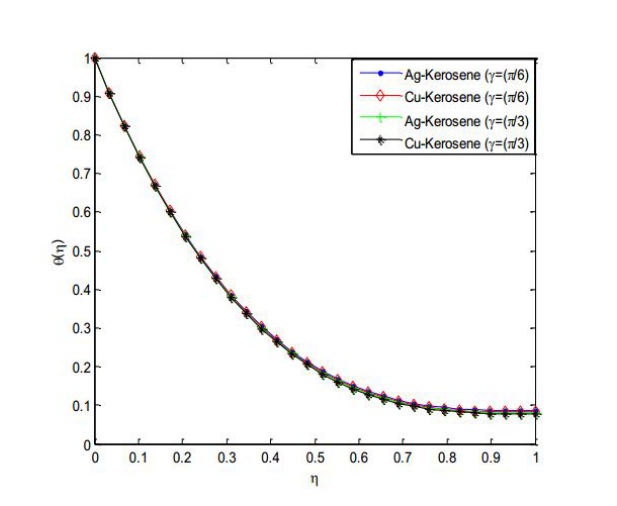
Figure 13. Effect of aligned angle on the fluid temperature distribution